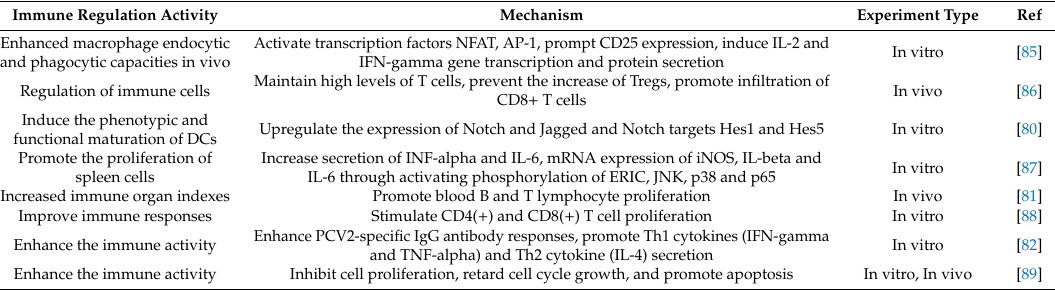
Table 4. Immune regulation activity and mechanisms of LBPs.